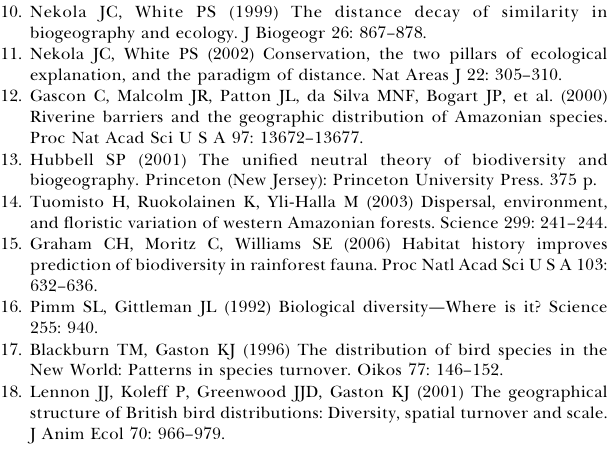
Figure S2. Bird Beta-Diversity Based on Both Breeding and Non- Breeding Ranges Beta-diversity ( b sim-d ) values are divided into 20 quantiles, repre- sented by warm (higher b sim-d ) to cool (lower b sim-d ) colors. The scale accompanying the color ramp shows minimum, first quartile, median, third quartile, and maximum values of b sim-d . Found at doi:10.1371/journal.pbio.0050272.sg002 (210 KB PDF). Figure S3. Average Nearest-Neighbor Beta-Diversity of Amphibians, Birds, and Mammals Mapped Continuously across the Continental Western Hemisphere Average nearest-neighbor beta-diversity ( b sim ) values are divided into 20 quantiles, represented by warm (higher b sim ) to cool (lower b sim ) colors. The scale accompanying the color ramp shows minimum, first quartile, median, third quartile, and maximum values of b sim . Gray grid cells do not contain amphibian species. (A) Amphibians. (B) Birds. (C) Mammals. Found at doi:10.1371/journal.pbio.0050272.sg003 (503 KB PDF). Table S1. Correlations between Beta-Diversity ( b sim-d ) and Two Environmental Variables (Elevation and Number of Biome Edges of Grid Cells) Table S2. Mean Elevation and Mean Number of Biome Edges for Sets of the Highest 2.5% and Lowest 2.5% of Beta-Diversity Grid Cells Found at doi:10.1371/journal.pbio.0050272.st002 (56 KB PDF). Table S3. Correlations in Average Nearest-Neighbor Beta-Diversity ( b sim ) within the Western Hemisphere, Nearctic Realm, and Neotropical